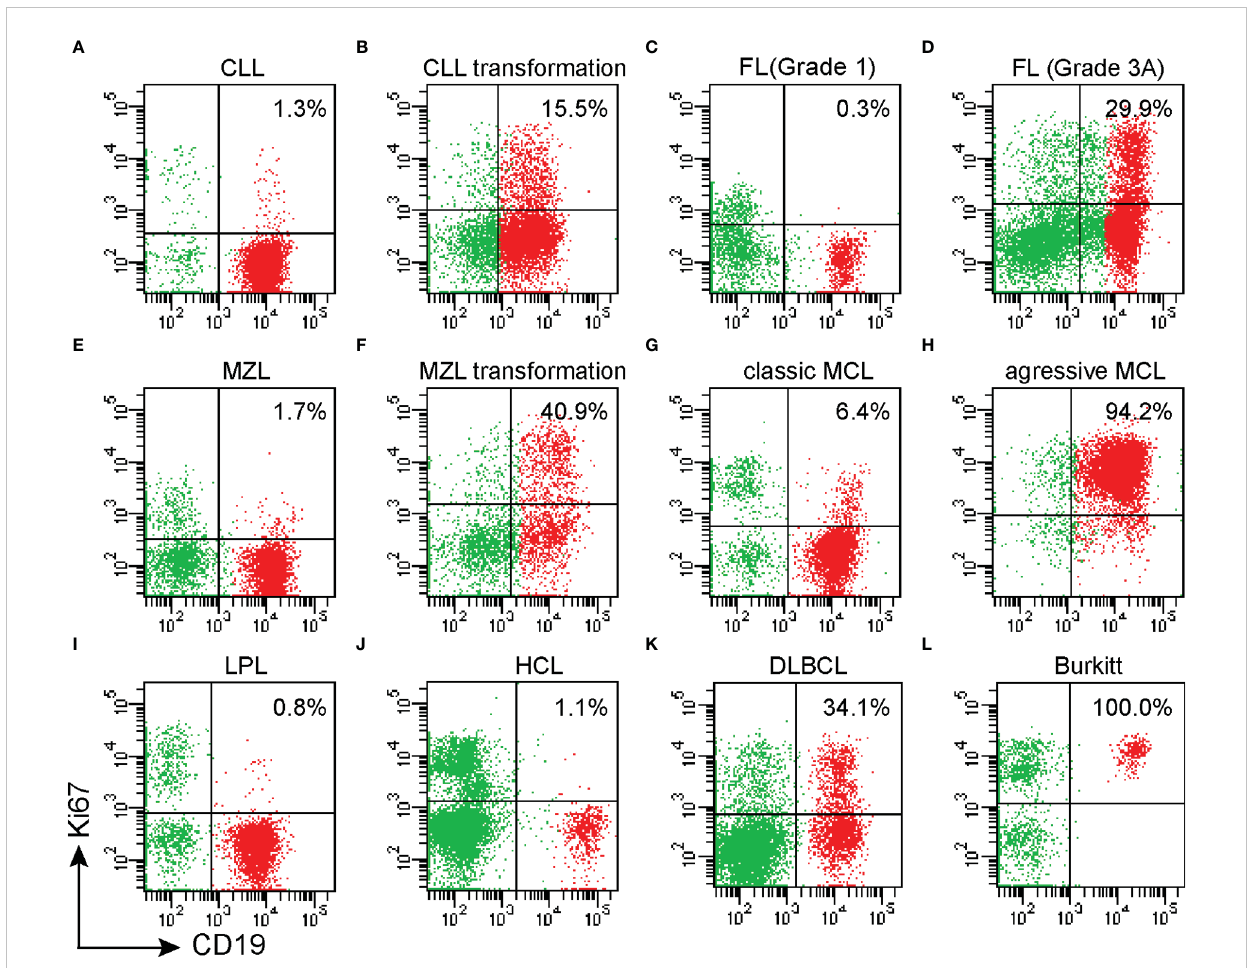
FIGURE 1 The expression of Ki67 in various non-Hodgkin B-cell lymphomas and transformed B-cell lymphomas was assessed by MFC; (A) chronic lymphocytic leukemia (CLL); (B) transformation of chronic lymphocytic leukemia (CLL); (C) Grade 1 Follicular lymphoma(FL); (D) Grade 3A FL; (E) . Nodal marginal zone lymphoma (MZL); (F) Nodal marginal zone lymphoma (MZL) progressed to Diffuse large B-cell lymphoma (DLBCL); (G) . Classic MCL; (H) Blastic variant MCL; (I) Lymphoplasmacytic lymphoma (LPL); (J) Hairy cell leukemia (HCL); (K) Diffuse large B-cell lymphoma (DLBCL); (L) Burkitt